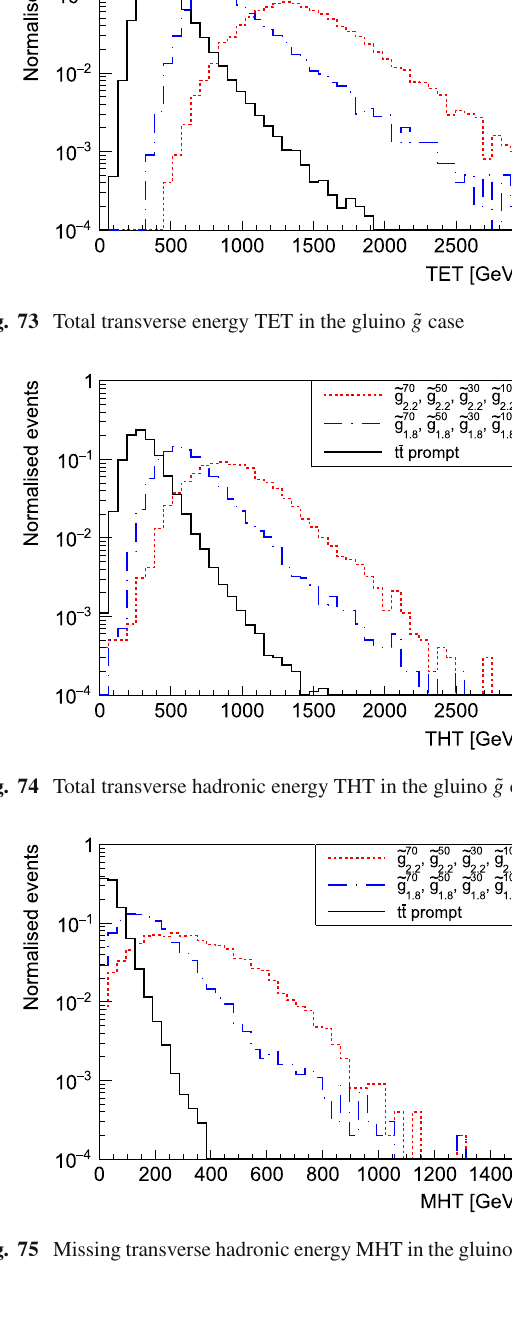
crucial for experimentalists to define a strategy for triggering on the signal events. Traditional observables used for prompt physics can be relevant to the signal topologies studied in this